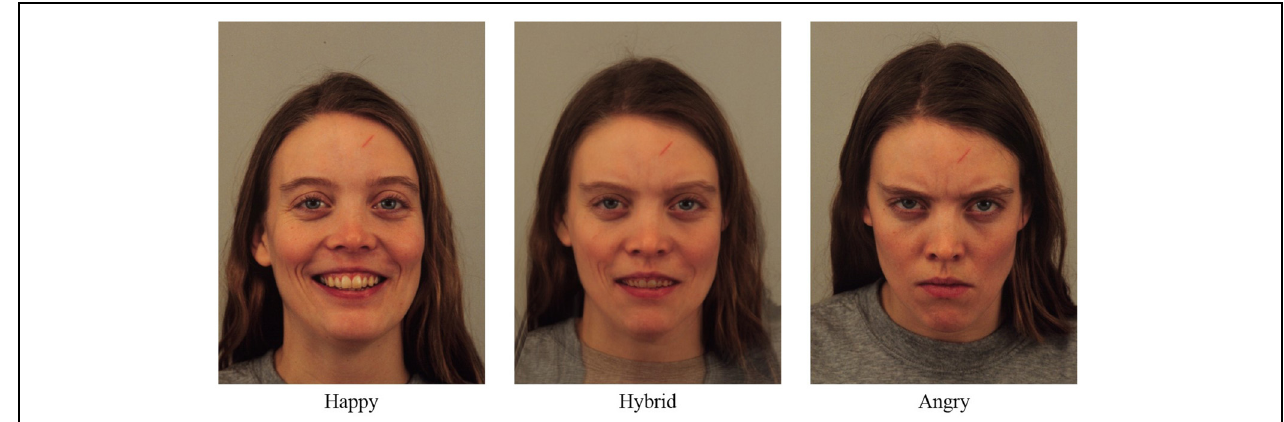
FIGURE 1 | Example of hybrid face.